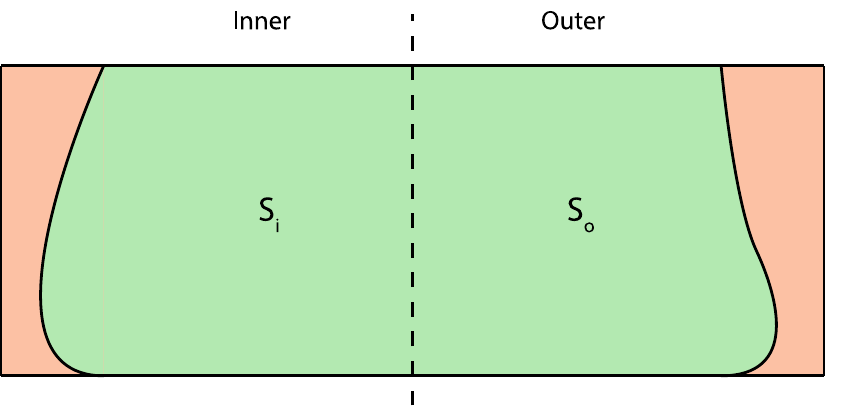
Figure 6. The illustration of the mass distribution ratio [71].